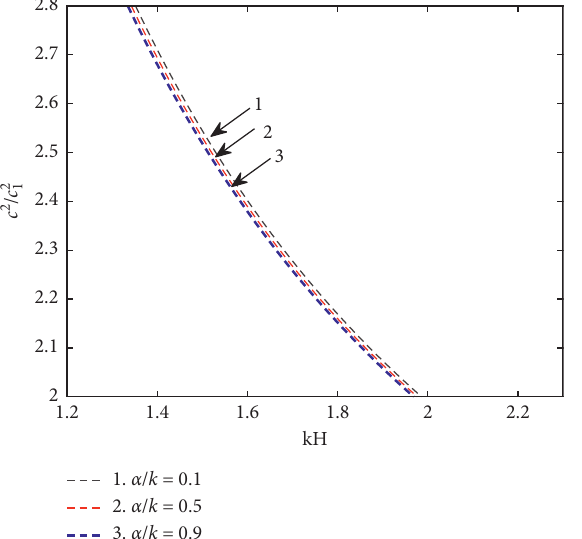
Figure 4: Model-I: effect of the initial stress ( P /2 L ) under rigid mountain surface.